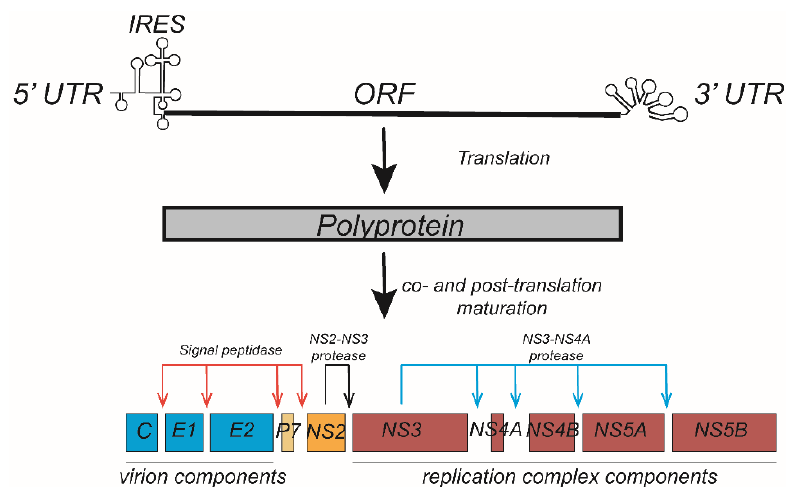
Figure 2. Hepatitis C virus (HCV) genome translation and polyprotein processing. The HCV genome contains an open reading frame flanked by 5′ and 3′ untranslated regions (UTRs) and encodes an approximately 3000 aa polyprotein. Translation of the polyprotein is mediated by an internal ribosome entry site (IRES) within the 5′ UTR and is processed into ten viral proteins through a co- and post-translation maturation process. The virion components (core, E1, and E2 proteins) and p7 are cleaved from the polyprotein by cellular signal peptidase. NS2 is cleaved from NS3 by the protease activity of NS2, while the viral replication components (NS3-NS5B) are cleaved from one another by the NS3-4A protease.